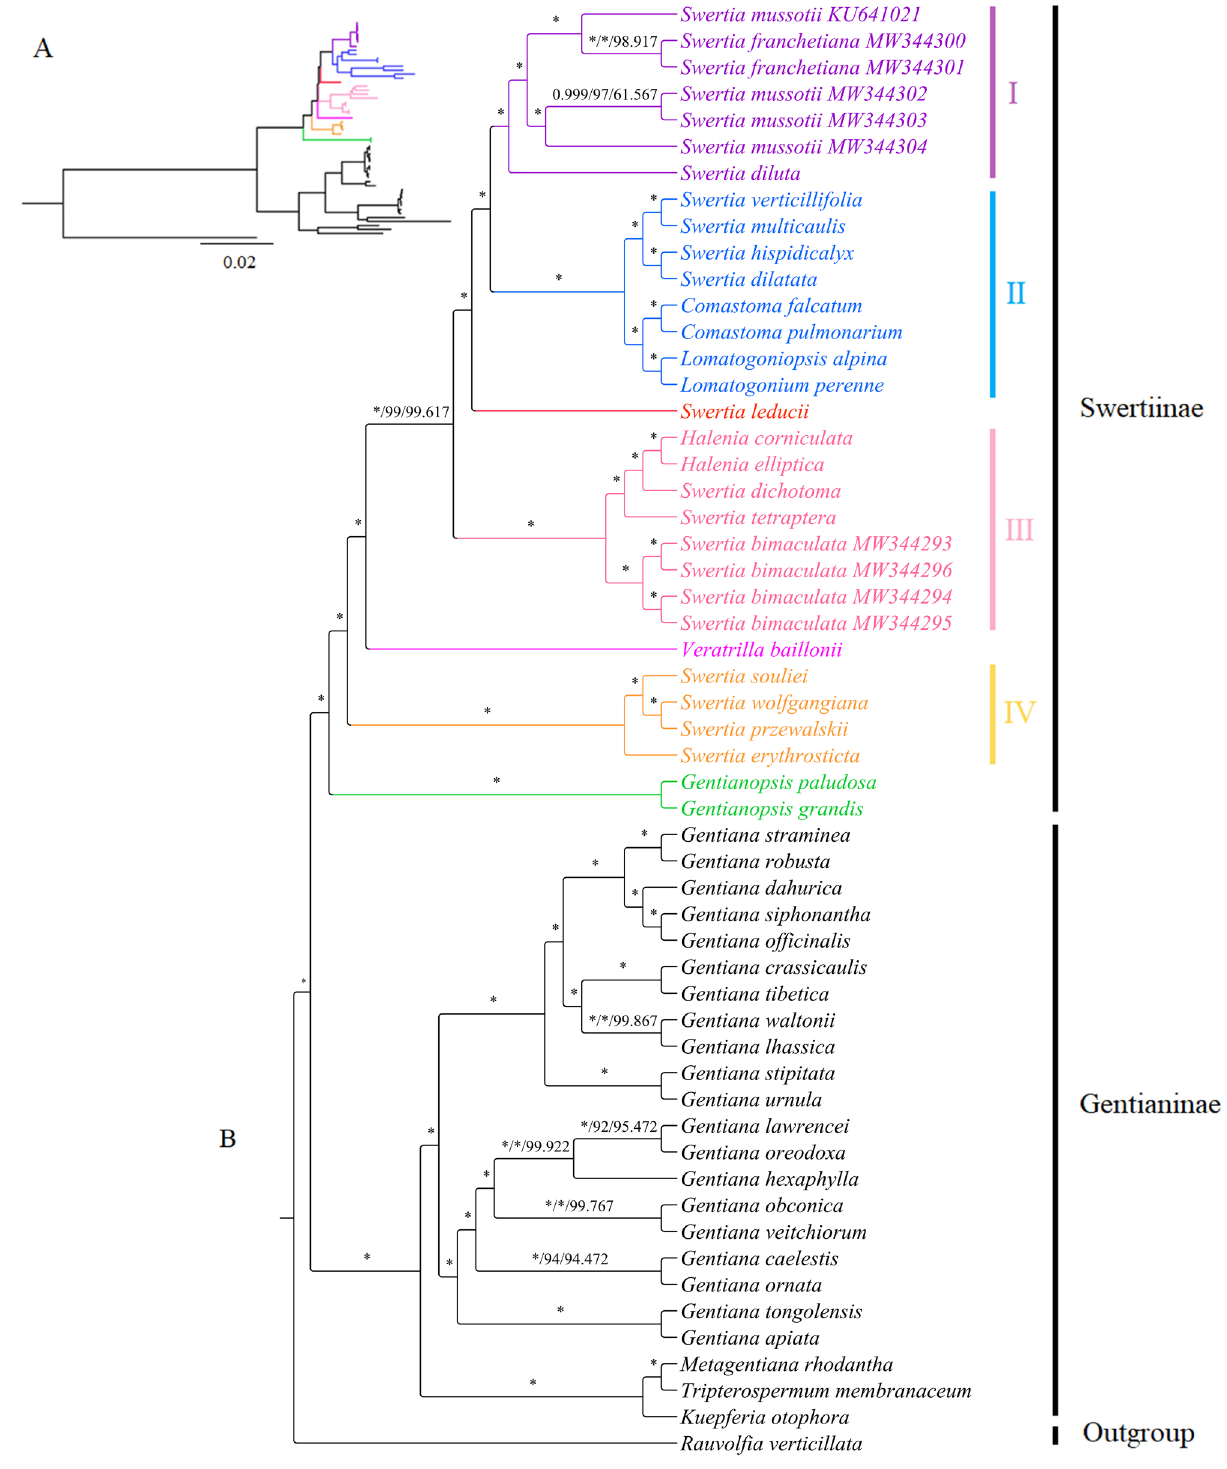
Figure 4 – Phylogenetic tree of 54 Gentianeae species and one outgroup based on the complete chloroplast genomes. A: tree with branch lengths; B: tree without branch lengths. Supporting values are shown in the form of BI/ML/MP. The symbol * indicates full support. Abbreviations: BI: Bayesian inference; ML: maximum likelihood; MP: maximum